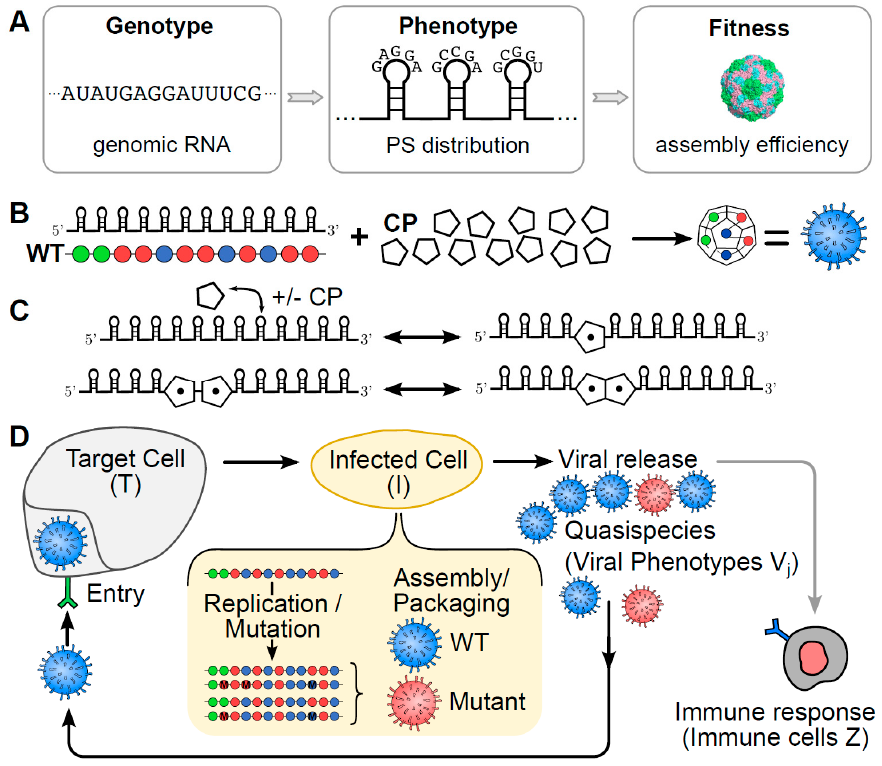
Figure 1. Schematic of the viral infection model. ( A ) The impact of the PS distribution (phenotype) of a vRNA (genotype) on virus assembly efficiency (a proxy for fitness) is captured via a genotype-phenotype-fitness map; ( B ) viral particles are represented as dodecahedral geometries formed from 12 CPs akin to those seen in Picornaviruses. These assemble around vRNAs with 12 PS binding sites, indicated here as strings of beads colour-coded according to their affinity for the CP (with green, blue and red representing strong, intermediate and weak interactions, respectively); ( C ) the interactions between PSs and CPs follow a set of assembly reactions in which CPs are recruited onto the vRNA templates, and neighbouring, bound CPs interact to form the CP-CP contacts required for completion of the capsid shell; ( D ) the different steps of the replication cycle include viral entry into target cells T, replication/mutation and assembly within the infected host cell I, and release of viral particles V into the surrounding medium. Our population level model explicitly contains details of the replication and assembly steps inside the infected cell (shown highlighted in yellow). The immune system removes viral particles dependent on the number of immune cells